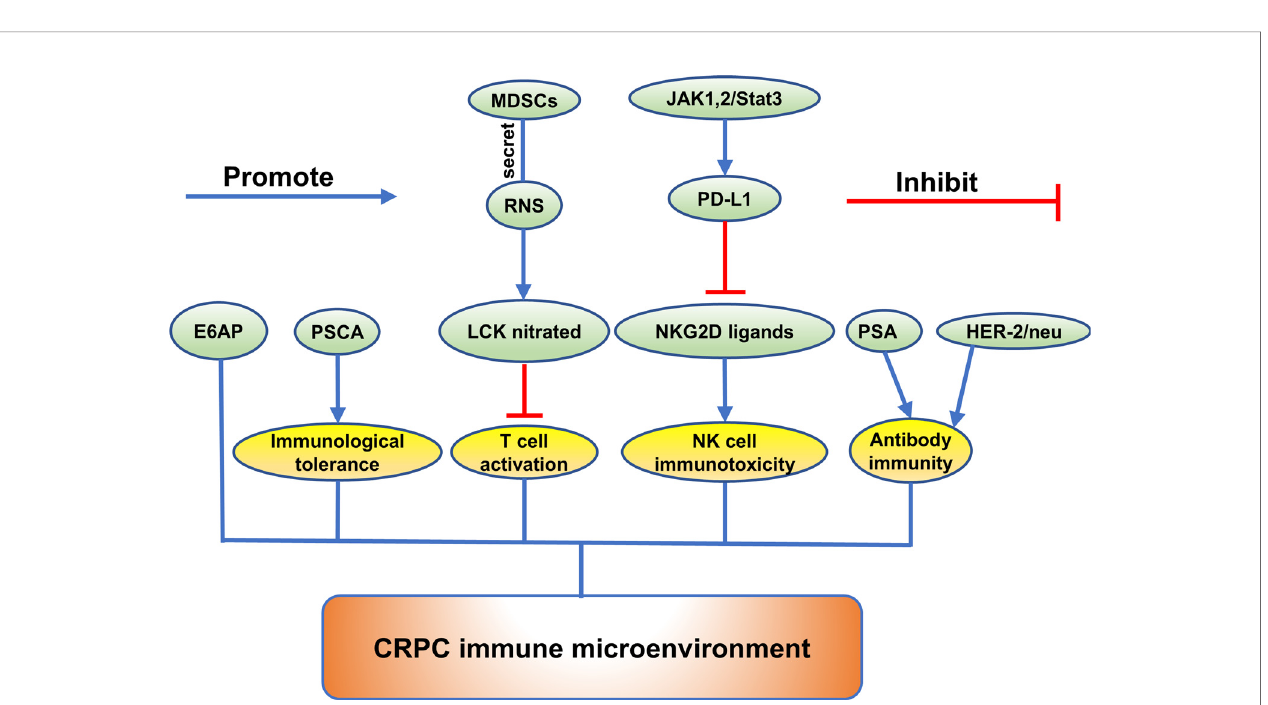
FIGURE 3 | The role of emerging proteins in CRPC immune